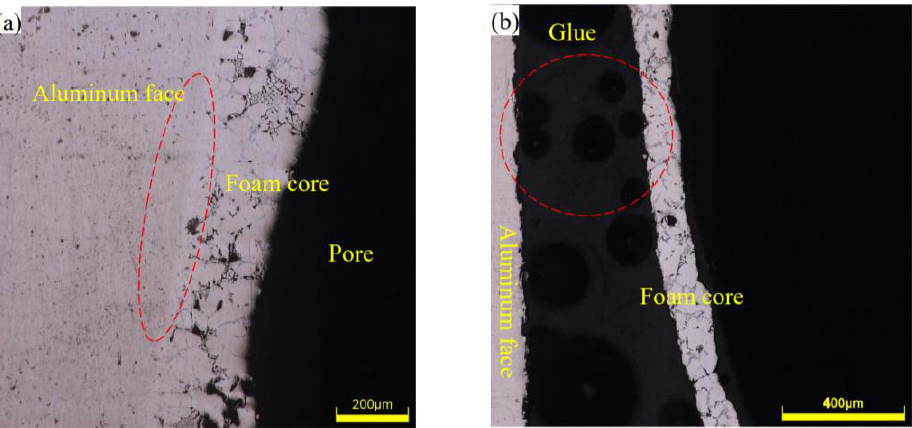
Figure 4. Microscopic interface: ( a ) the powder metallurgy method, ( b ) the adhesive